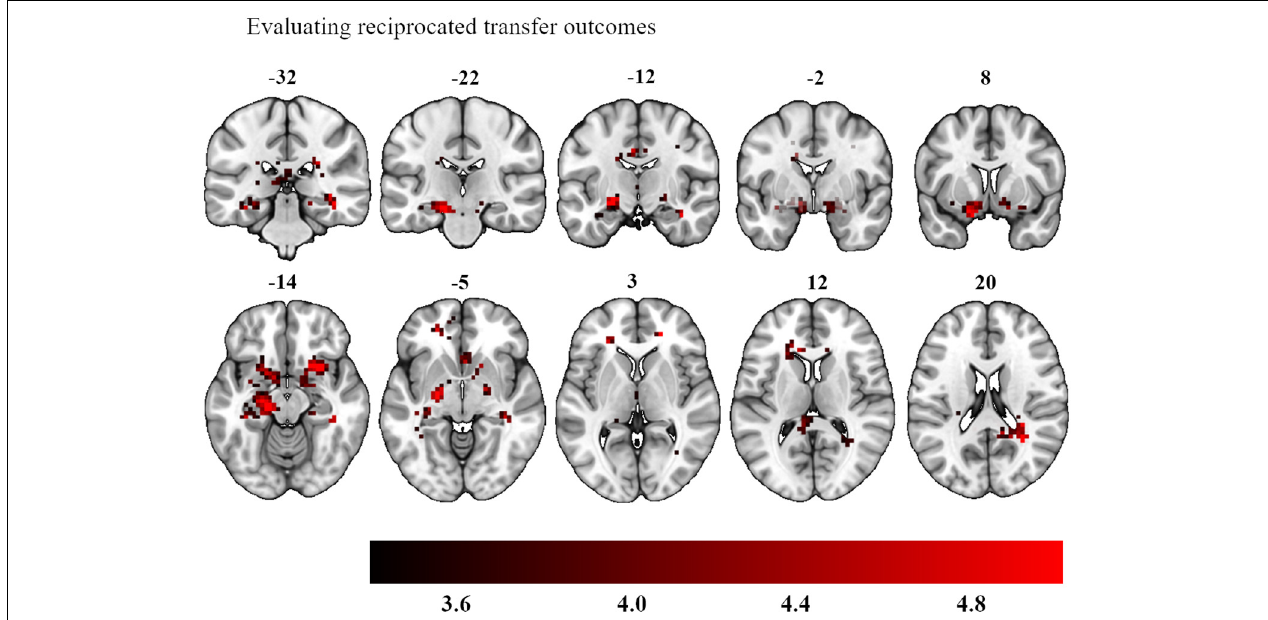
FIGURE 6 | Bilateral activation in the amygdala, left ventral striatum and right dorsal striatum as a function of participants’ investment choices during the delivery of their outcomes. The color map defines the strength of the contrast’s T -scores (Statistical maps with an initial threshold of uncorrected p < 0.001 were established and were subsequently corrected for multiple comparisons using a Family Wise Error corrected cluster threshold of p <